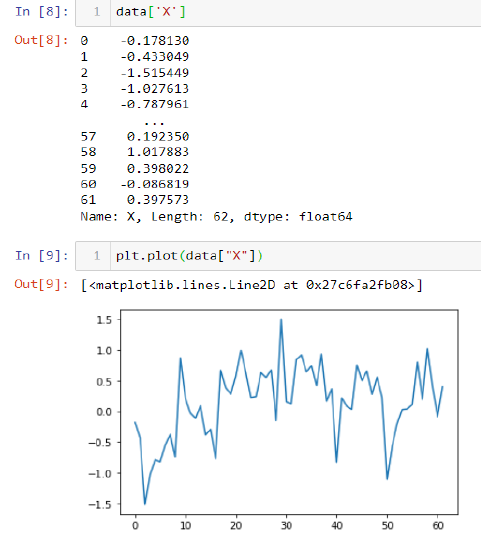
Figure 41. Visualization of data ( x -axis).